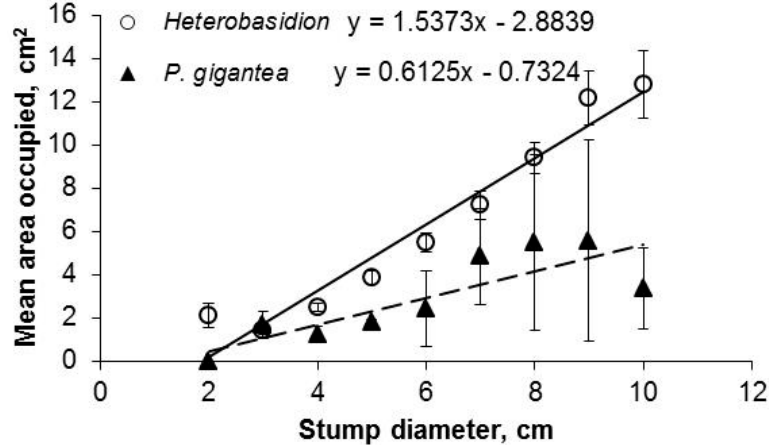
Figure 2. Mean stump area occupied by Heterobasidion and Phlebiopsis gigantea in stump cross-sections cut from suppressed spruce stumps in relation to stump diameter.